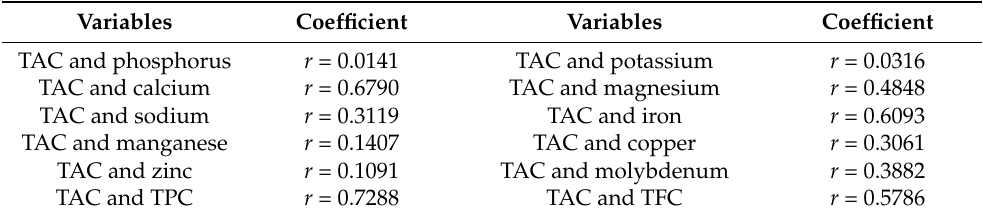
Table 8. Selected correlation coefficients between TAC-DPPH and mineral content, TPC and